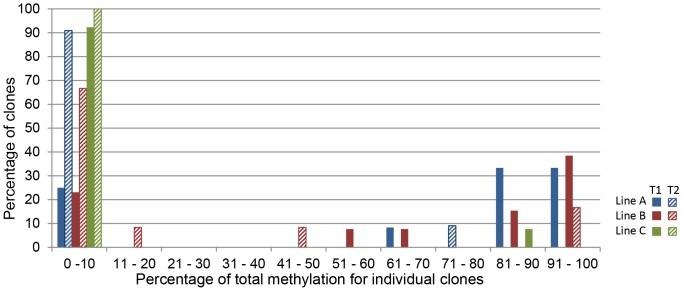
Analysis of hypermethylation rates for RPSmod4 clones in the next generation.Classification of RPSmod4 clones according to percentage of total methylation for each independent line. T1 generations (solid bars) show a distinct bimodal distribution of <10% and >80% methylation. For line A, the majority of clones in the T1 generation are highly methylated. Line B shows fewer highly methylated clones and line C shows mostly unmethylated clones. All lines show an increase in unmethylated clones in the T2 generation (striped bars). Line A has no clones showing >80% methylation. Line B shows 2 out of 12 clones still having high levels of methylation and 2 clones with intermediate levels. For line C, no clones showed significant methylation in the T2 generation.